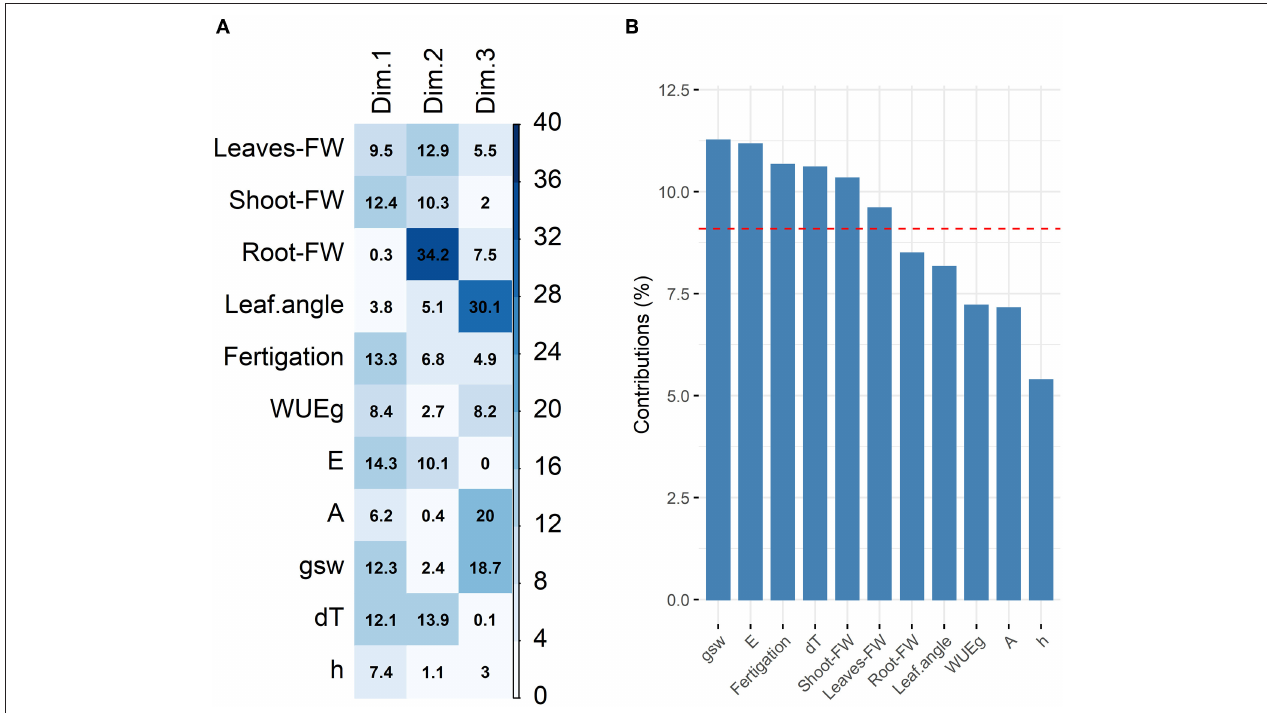
FIGURE 3 | Variable contribution and correlation with PCs. (A) Correlation plot to evaluate variable contribution to single PCs with an eigenvalue bigger than one. Variable contribution to PCs is indicated numerically as percentage and by color for easier pattern recognition. (B) Total contribution of variables to PC1-3. Expected average contribution is indicated by a dashed red line. The depictured traits are leaf angles, leaf color (h), stomatal conductance (g sw ), transpiration (E), assimilation (A), intrinsic water use efficiency (WUE g ), total fresh weight (FW) of root, shoot and leave, as well as the fertigation and leaf temperature difference